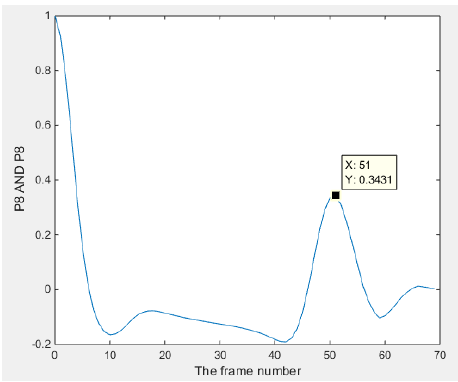
Figure 8. Plots of cross-correlated results using pixel 8.